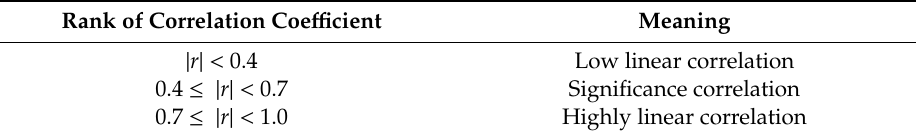
Table 5. Criteria for a correlation coe ffi cient.